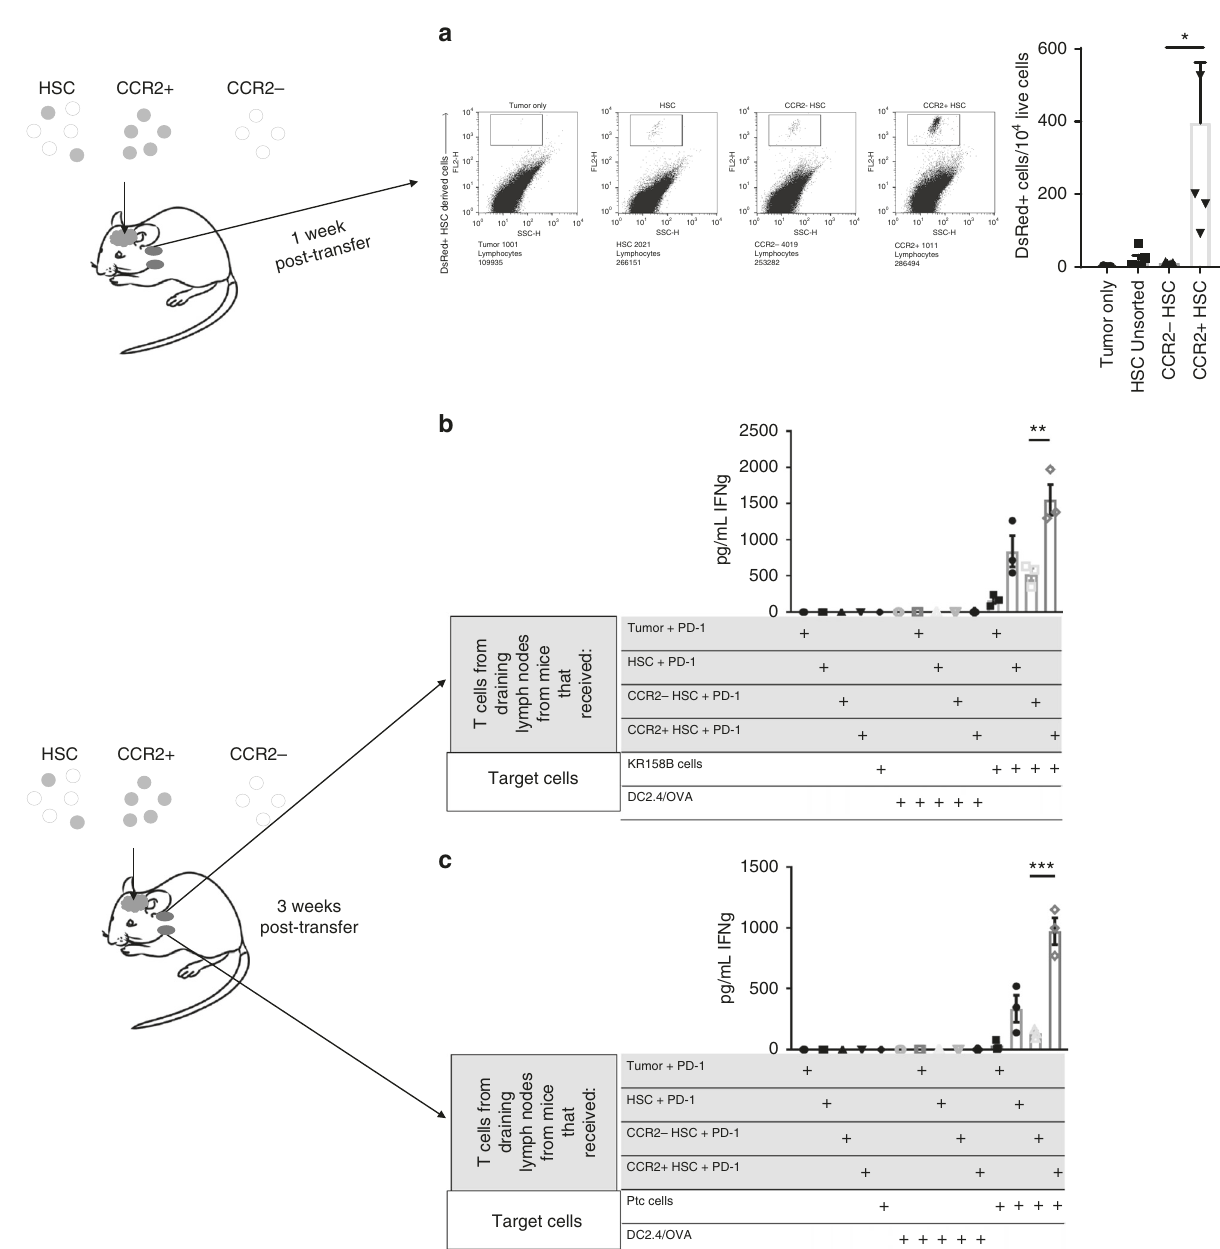
Fig. 5 CCR2 + HSCs cross-prime endogenous T lymphocytes. a Either HSCs, CCR2 + HSCs, or CCR2 − HSCs isolated from DsRed + mice were stereotactically injected into tumors of glioma-bearing mice. DsRed + cells were then observed in draining lymph nodes 1 week post transfer, and relative amounts of DsRed + cells between groups was compared, CCR2 + HSCs vs. CCR2 − HSCs (* p = 0.021, Mann – Whitney, n = 5 mice per group). b Either HSCs, CCR2 + HSCs, or CCR2 − HSCs were isolated from DsRed + mice, then were stereotactically injected directly into tumors of glioma- or medulloblastoma- bearing mice followed by systemic administration of PD-1. Three weeks post transfer, draining lymph nodes were harvested and T-cells were isolated from the lymph nodes using magnetic bead isolation. These T-cells were then used as effector cells against tumor cell targets in a co-culture assay. This was conducted in KR158B glioma-bearing mice, and Ptc medulloblastoma-bearing mice, and IFN γ secretion was measured after the co-culture. T cells harvested from b KR158B glioma-bearing mice that received CCR2 + HSCs secreted an average of 1549.99 ± 212.621 pg/ml IFN γ , which is signi fi cantly more that T-cells derived from mice that received CCR2 − HSCs that contained 522.183 ± 87.32 pg/ml IFN γ (** p = 0.0111, two-tailed t -test). c T cells harvested from Ptc medulloblastoma-bearing mice that received CCR2 + HSCs secreted an average of 972.2± 110.6 pg/ml IFN γ , which is signi fi cantly more that T-cells derived from mice that received CCR2 − HSCs that contained 132.6 ± 20.74 pg/ml IFN γ (*** p = 0.0017, two-tailed t -test). All error bars represent